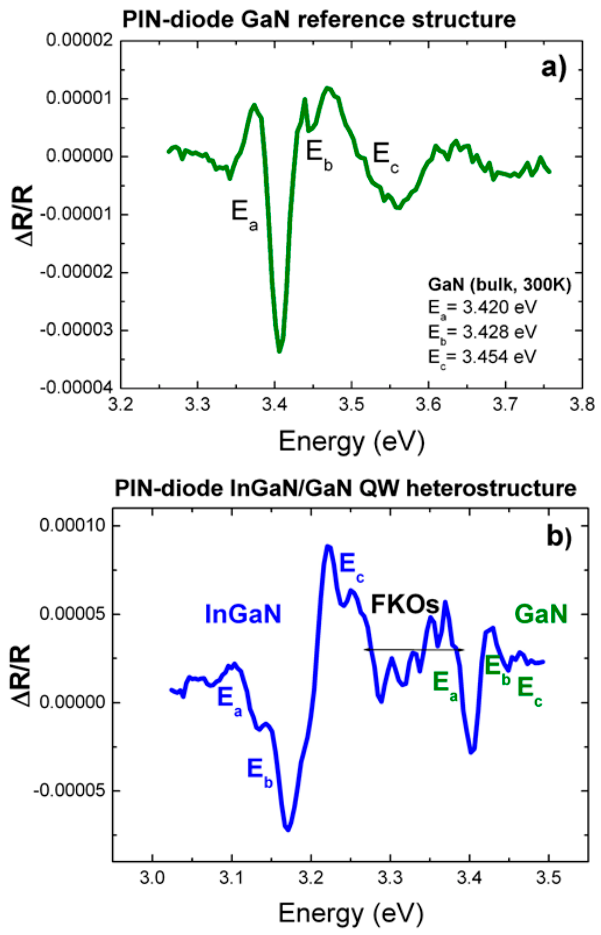
Figure 4. ER spectra of PIN-diodes based on ( a ) the GaN reference sample and ( b ) the In 0.055 Ga 0.945 N/GaN DHS with three-split valence bands E a , E b , and E c of the wurtzite crystal structure. A plot of the FKO extrema E m as a function of redefined index yields a straight line with slope Θ = 0.01536 eV and ordinate-intercept the E a transition energy (fundamental gap energy E 0 ) of the In 0.055 Ga 0.945 N/GaN quantum well heterostructure, E 0 = 3.260 ± 0.002 eV, averaged over several measurements, <E 0 > = 3.248 ± 0.006 eV. The bandgap energies of